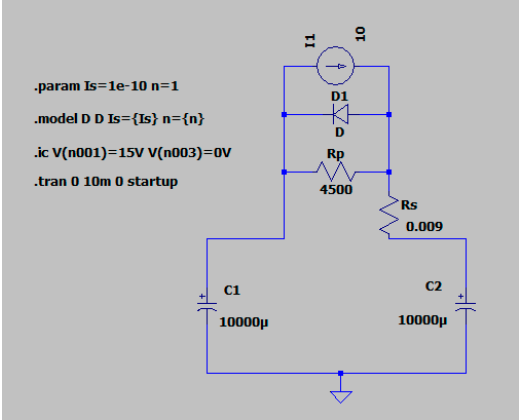
Figure 6. Circuit simulated in LTSpice for estimating the necessary capacitance for C 1 and C 2 .